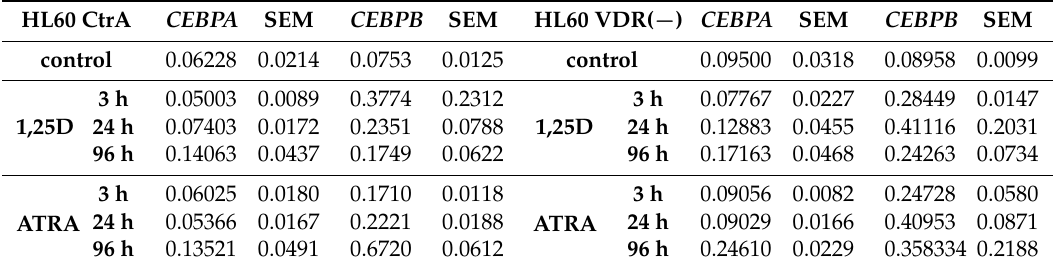
Table A4. Comparative quantification of CEBP genes related to a reference GAPDH gene in HL60-CtrA and HL60-VDR( − ) cells.